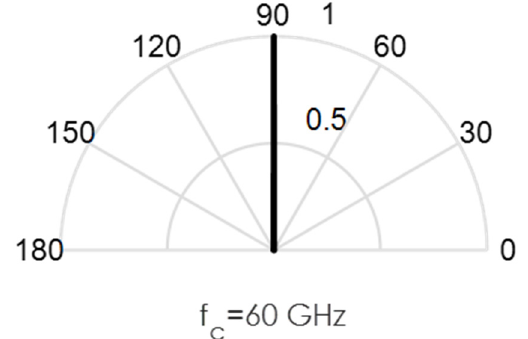
Figure 7. Directional beams produced by uniform linear arrays (ULA) operating at 60 GHz; 400 array elements with λ /2-spacing; 400 × 1 steering vector A = [1 1 1 . . .